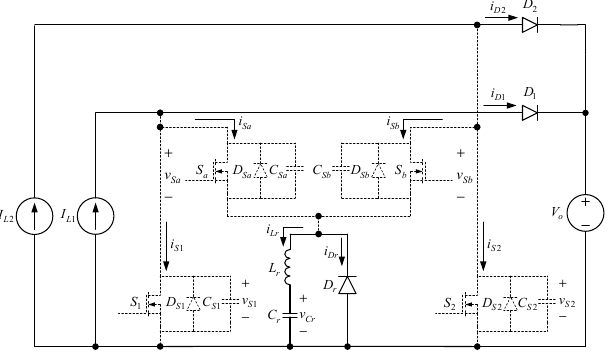
Figure 10. Current path in mode 7.